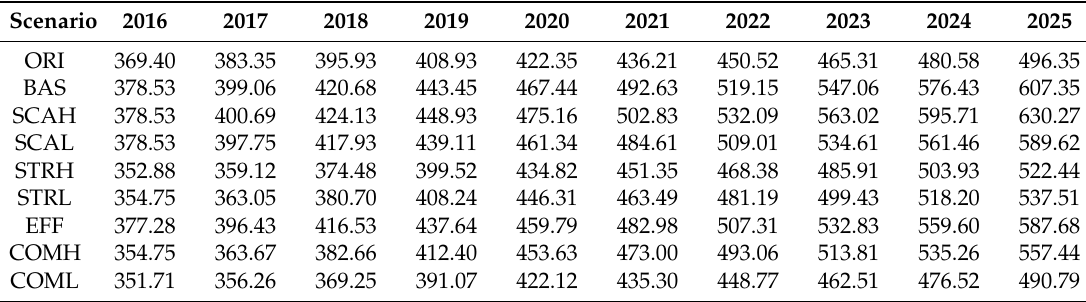
Table 8. The values of electricity demand in various possible scenarios (TW-h).